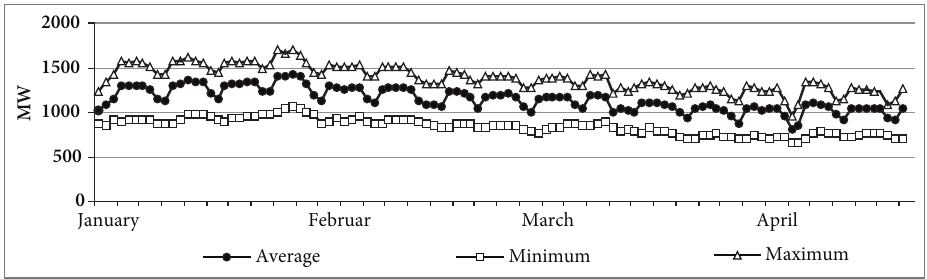
Fig. 1. The need for electricity capacity in Lithuania in January–April 2010, MW Note: consumption is given without system